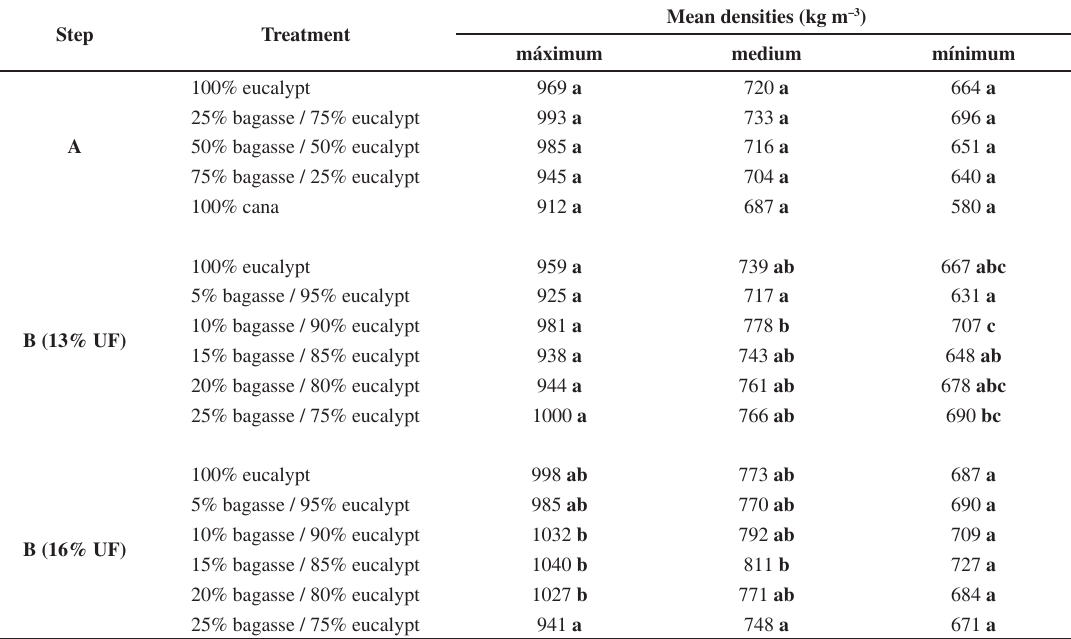
Table 2. Maximum, medium and minimum density from profiles obtained in GreCon densitometer, by stage and